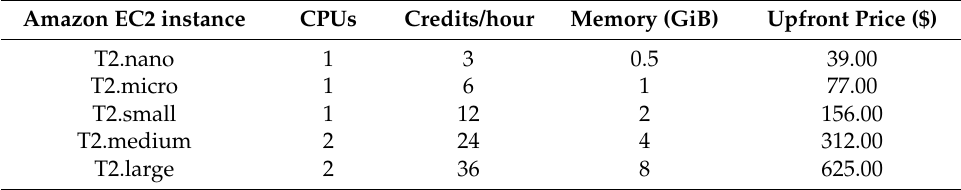
Table A1. Characteristics of the Amazon EC2 instances.